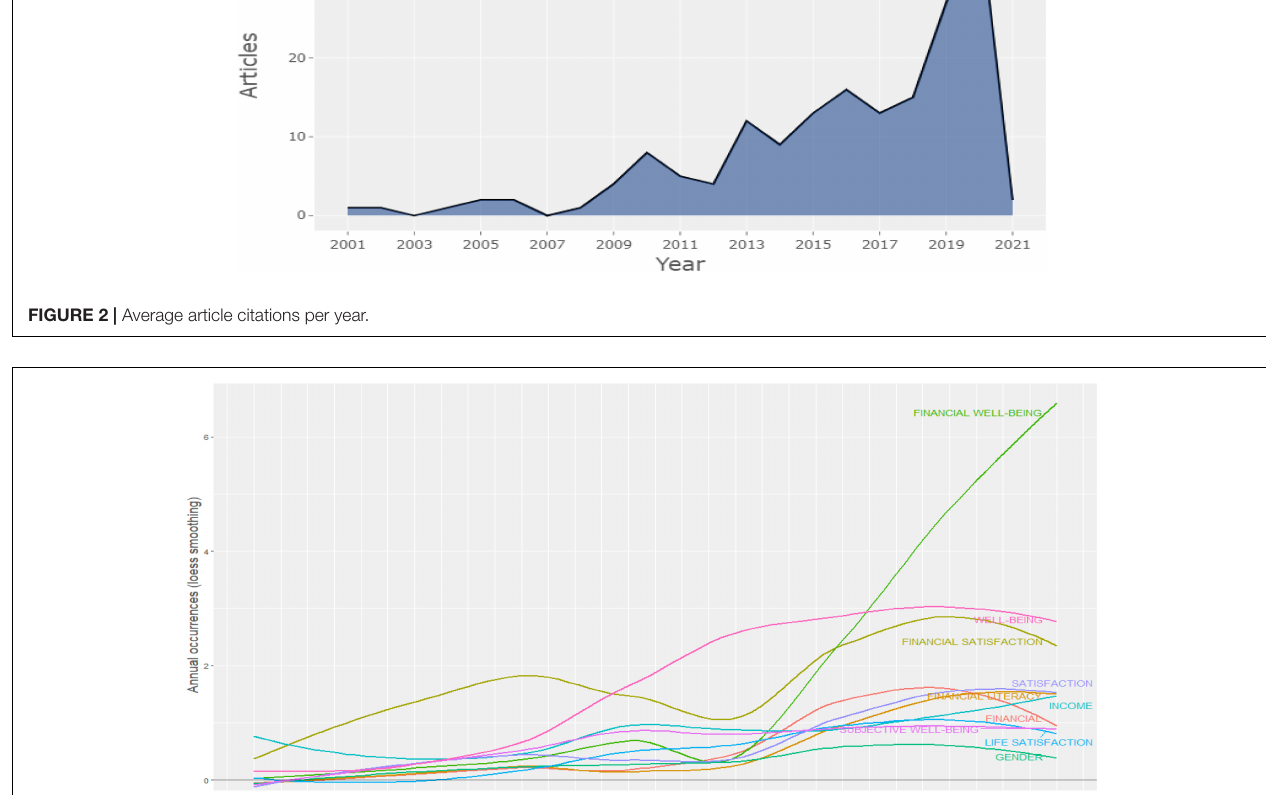
FIGURE 3 | Word dynamic